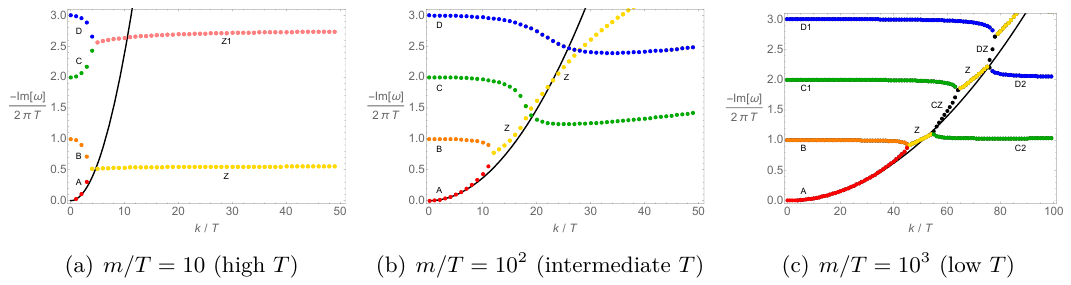
Figure 10 . Quasi-normal modes from high T to low T . All dots are quasi-normal modes and the black solid line is the charge diffusion mode (2.7). Note that the region around k/T ∼ 50 in figure 10(c) corresponds to figure